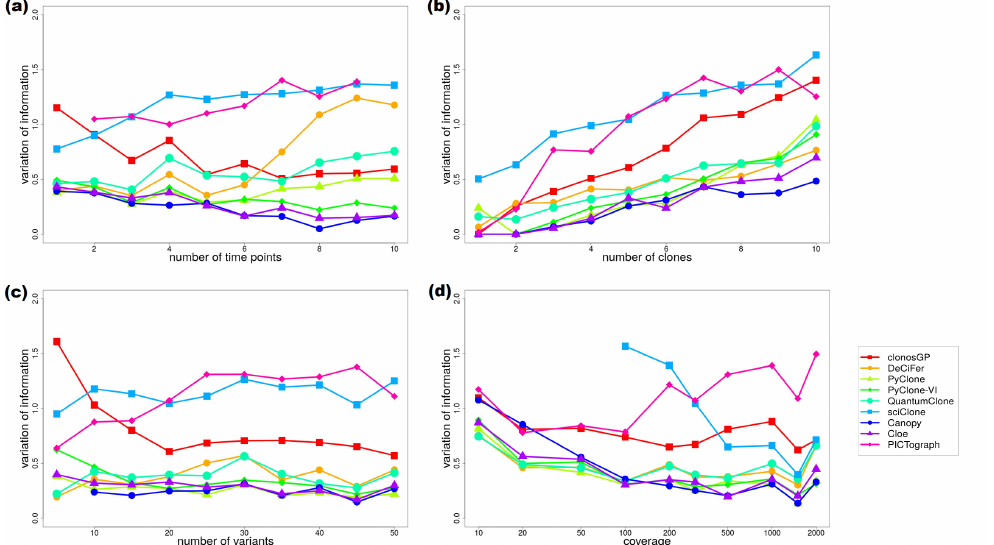
Figure 3. Variation of information comparing variant clustering performed using clonosGP, DeCiFer, PyClone, PyClone-VI, QuantumClone, sciClone, Canopy, Cloe, and PICTograph in the absence of CNVs to simulated truth. Three time points, five clones, 20 variants, and 300x coverage define the baseline configuration. We evaluate the influence of varying ( a ) number of time points; ( b ) number of clones; ( c ) number of variants; and ( d ) coverage. Of note, a missing dot indicates missing clustering results for all 10 patients per simulated data